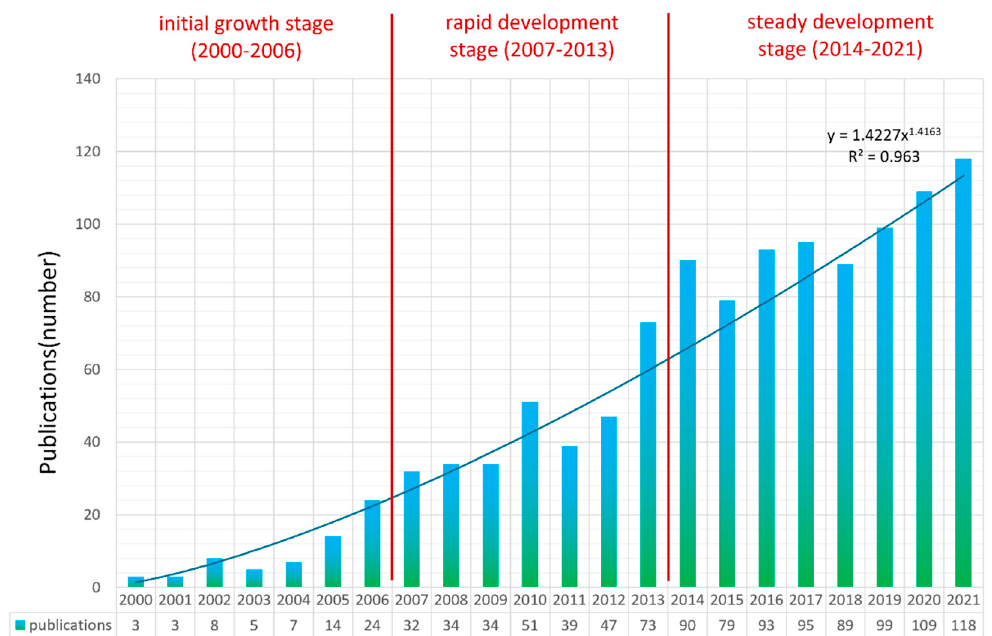
Figure 1. The total number of publications during 2000–2021. The number of annual publications and the three main stages in research on information communication in disasters are